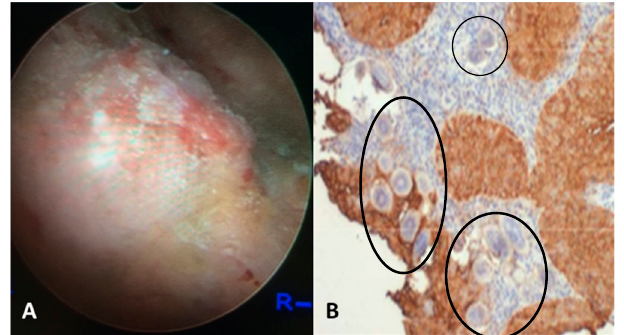
Figure 1. ( A ) Cystoscopy view of the posterior bladder mucosa with UGS lesions, granulomas, ulcers and tumor. ( B ) Histology from the bladder mass biopsy showing S. haematobium ova (black circles) and SCC of the bladder (expression of sialyl-Le a